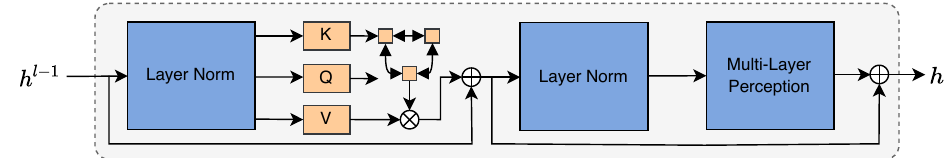
Figure 4. The schematic of the transformer